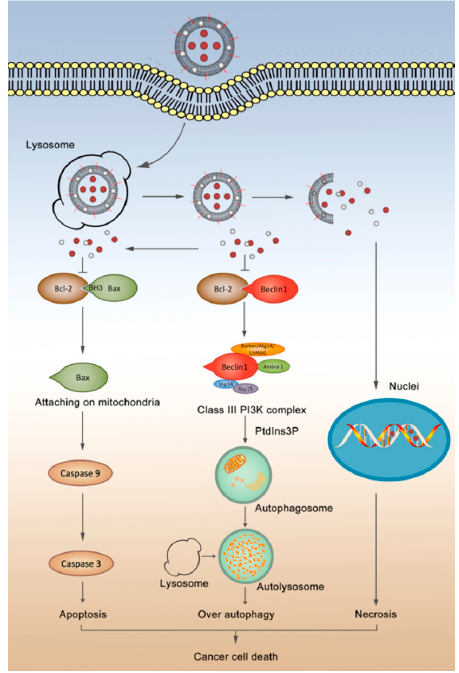
Figure 6. Illustration of heterogeneous cancer death induced by dihydroartemisinin plus epirubicin liposomes through autophagy, apoptosis and necrosis. The nanostructured dihydroartemisinin plus epirubicin liposomes were internalized by cancer cells, escaped from the lysosomes, and existed in two states: the raptured and intact liposomes. Drugs, which either are from the raptured